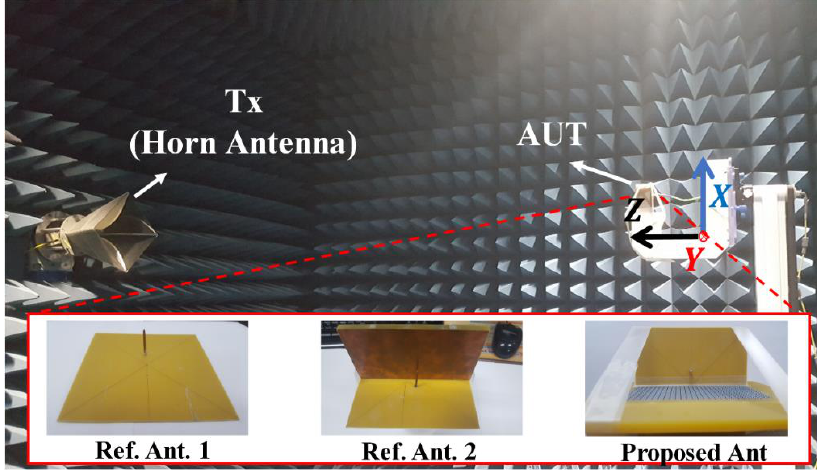
Figure 12. Radiation pattern measurement setup and fabricated antennas.